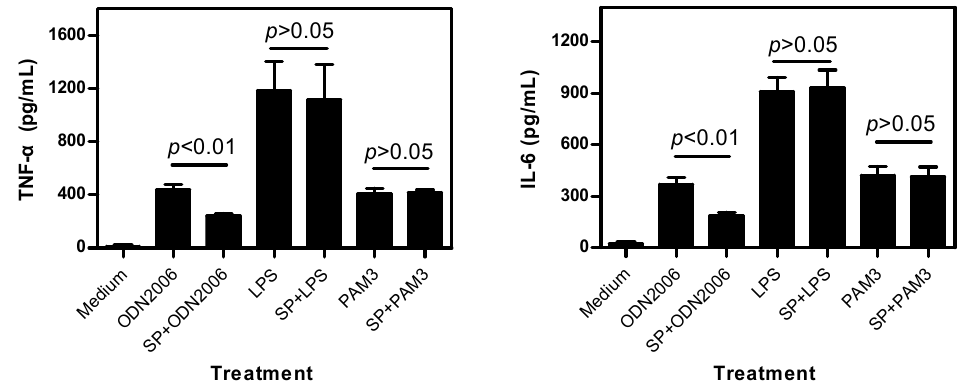
Figure 2. Synthetic peptide (SP) did not inhibit TNF- α and IL-6 release induced by lipopolysaccharide (LPS) or PAM3CSK4 (PAM3) from RAW264.7 cells. Experiments were performed as described in Figure 1. The concentrations of ODN2006, LPS, PAM3 and SP were 1.5 μ M, 20 ng/mL, 5 μ g/mL and 1.5 μ M, respectively. Data from one of three independent experiments are shown ( n = 3).